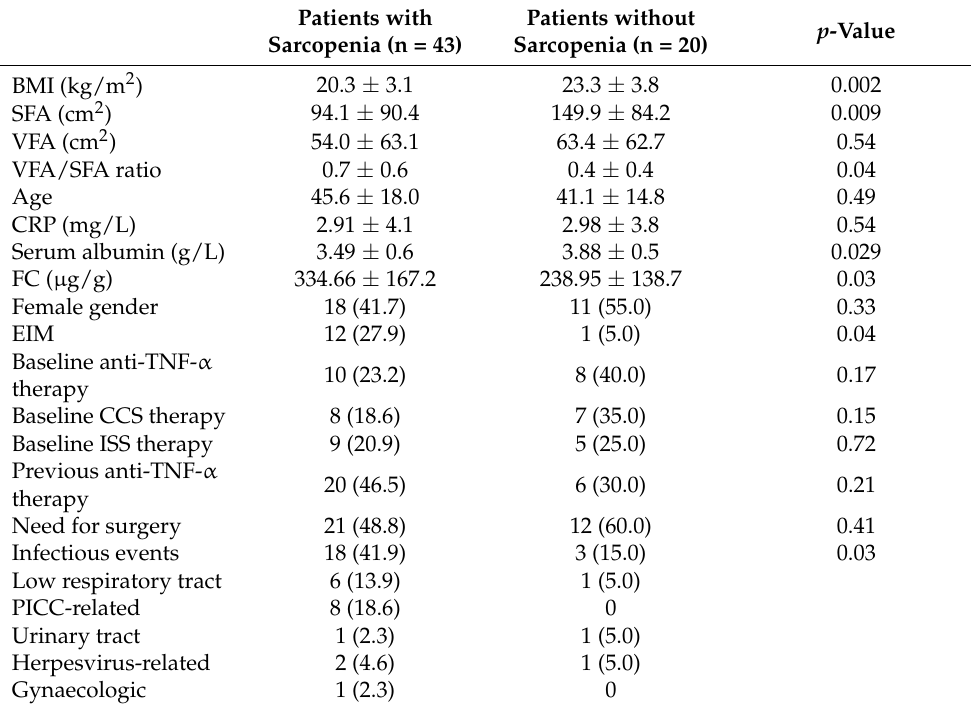
Table 2. Univariate analysis on anthropometry, patients’ characteristics and outcomes in the sar- copenic and non-sarcopenic cohort. Patients with Patients Sarcopenia (n = 43)